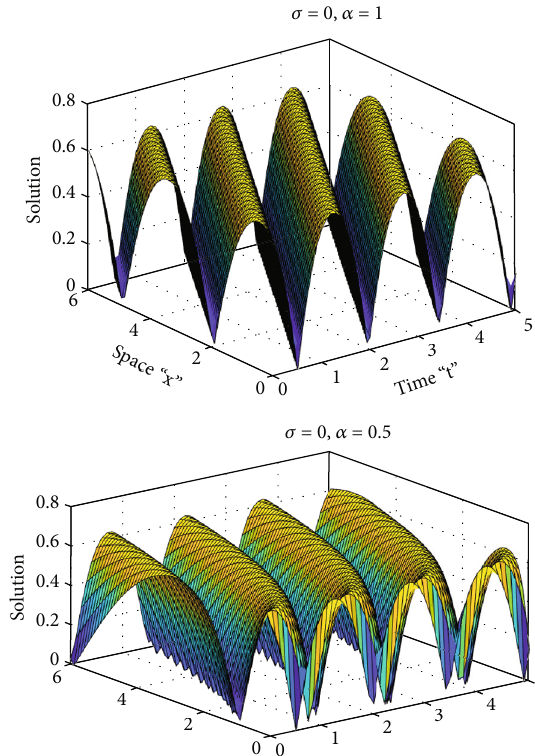
Figure 1: 3D diagrams of Equation